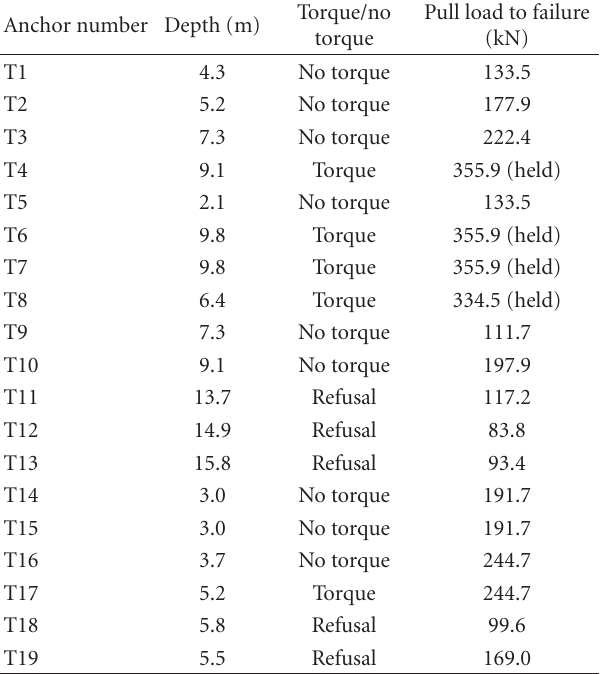
Table 2: Selected anchor pull test